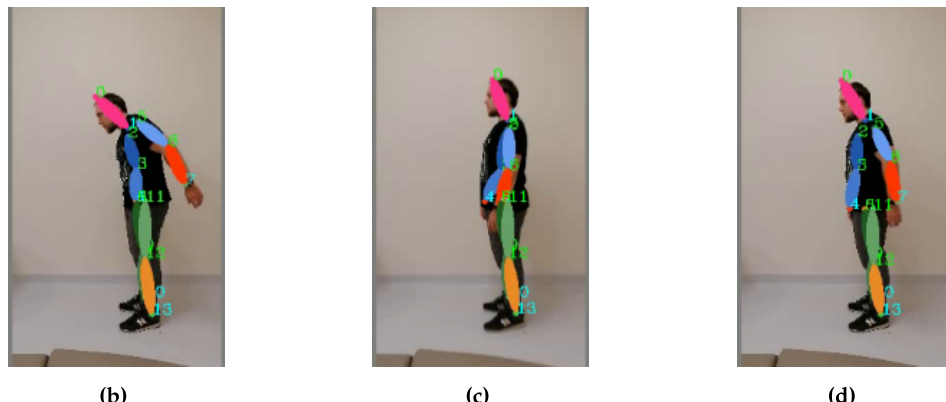
Figure 16. Arm raising with compensation: the motion sequence ( a – d ) starts on the left and ends on the